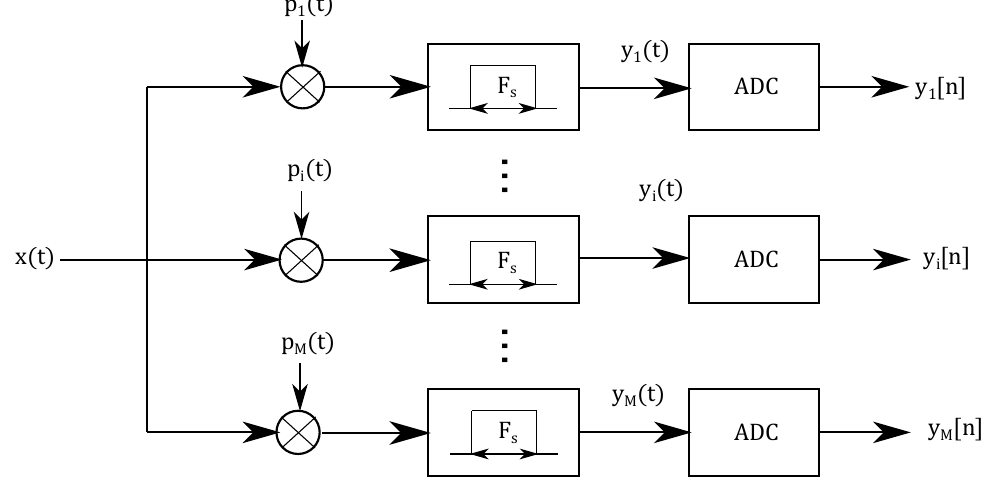
Figure 1. Block diagram of the MWC